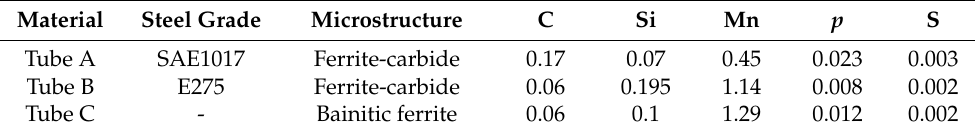
Table 2. Material types and chemical components of the steel tubes (mass%).